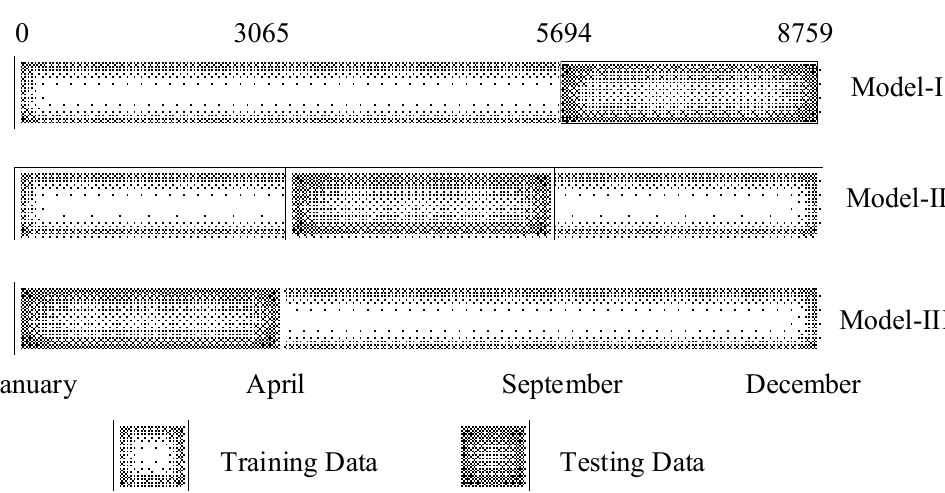
Figure 8. Three different cross-validation paradigms used in training and testing.